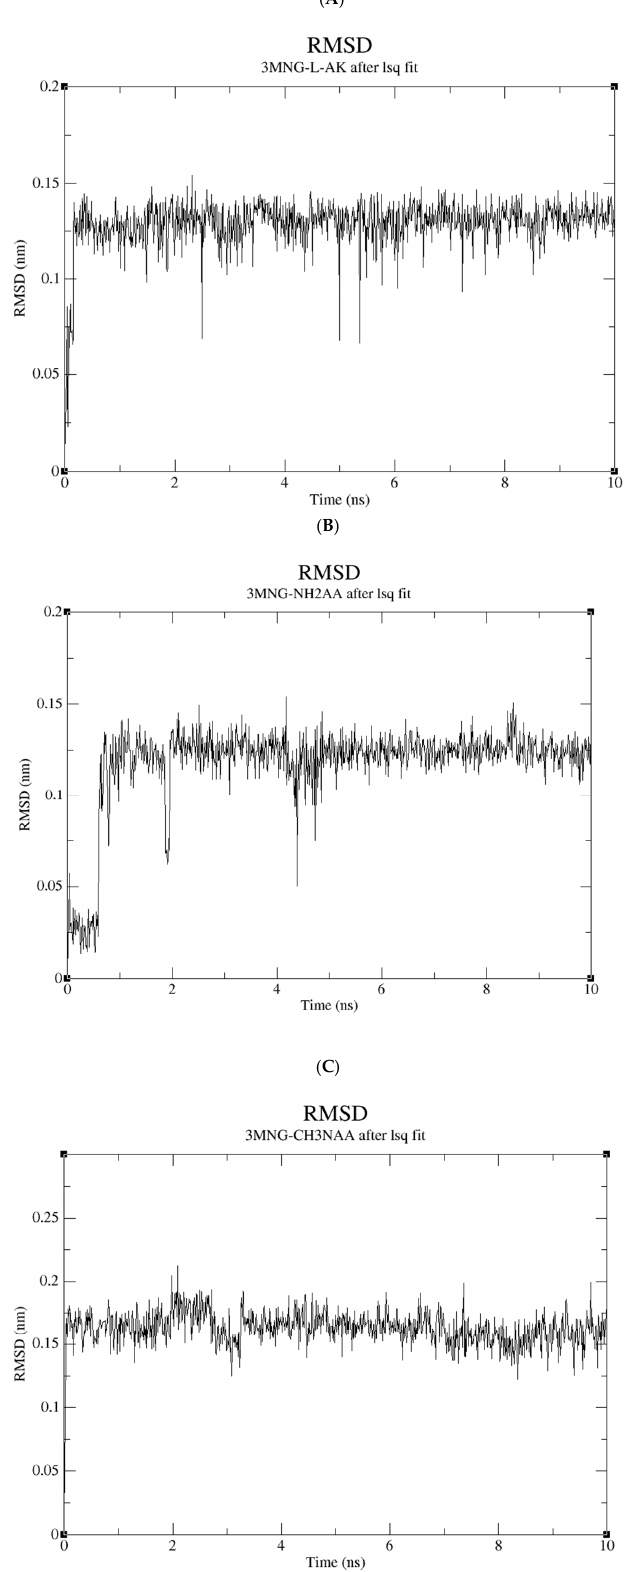
Figure 11. RMSD of AA ( A ), NH 2 AA (D1) ( B ), and CH 3 NHAA (D2) ( C ). This further suggests the equivalency of the binding modes of AA with D1 and D2.